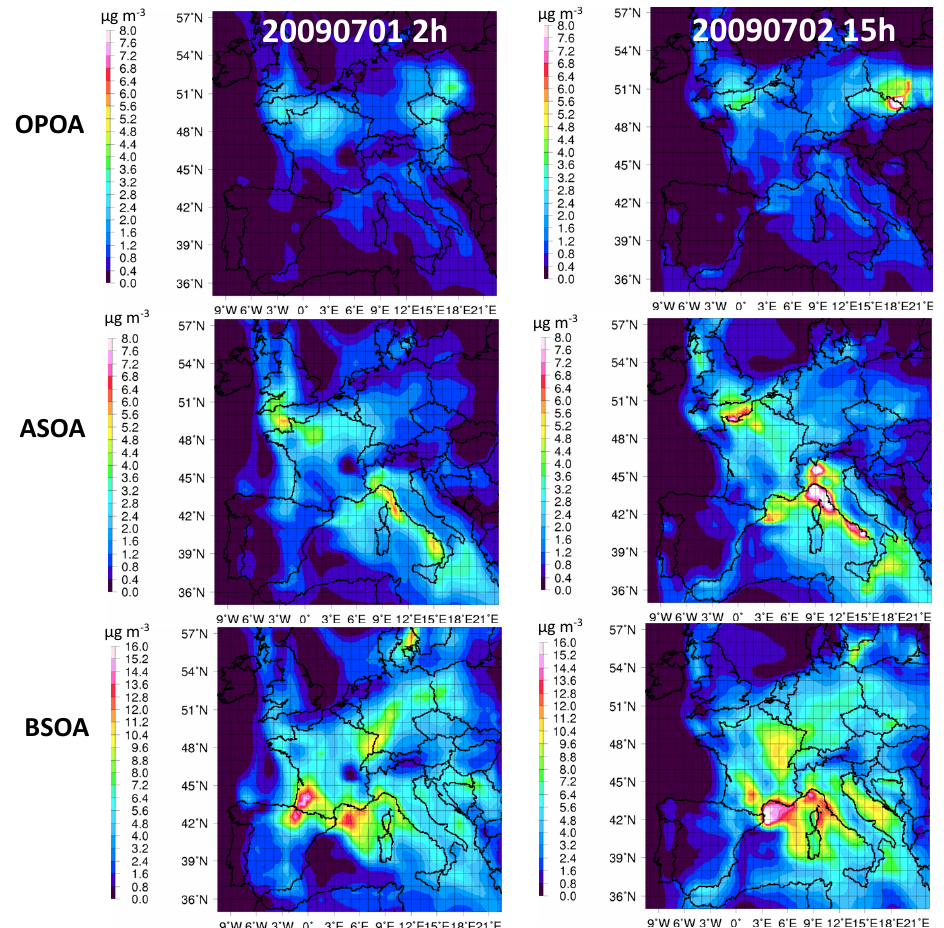
Fig. 10 Spatial OPOA, ASOA, BSOA distributions at surface level at 2h LT on July 1 st (left) and 15h LT on 2 nd (right) Fig. 10. Spatial OPOA, ASOA and BSOA distributions at surface level at 02:00LT on 1 July (left) and 15:00LT on 2 July (right).